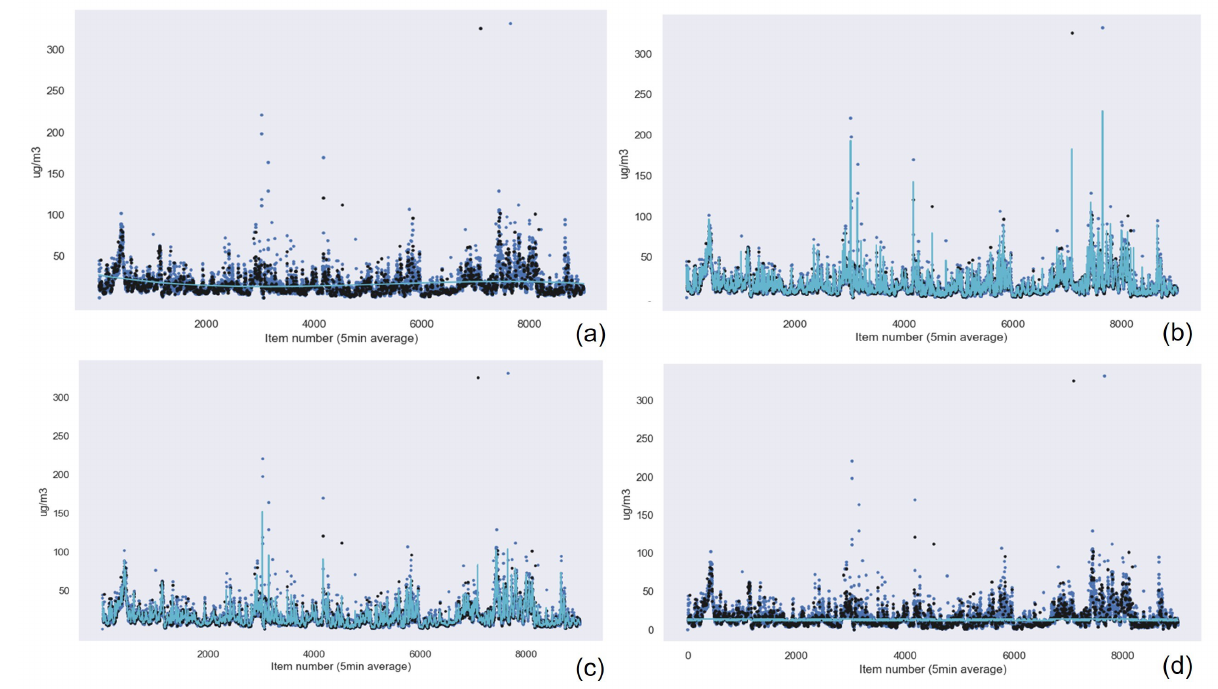
Figure A16. PM 1 results of the articulate matter measuring device # 2 with outliers for ( a ) Linear Re- gression ( b ) Random Forest Regression ( c ) KNN and ( d ) Support Vector Machine, and without outliers for ( e ) Linear Regression ( f ) Random Forest Regression ( g ) KNN and ( h ) Support Vector Machine.